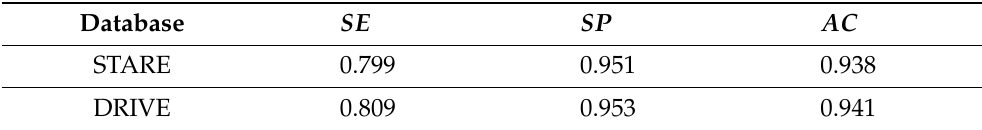
Table 5. Analysis of Performance on Challenging images.